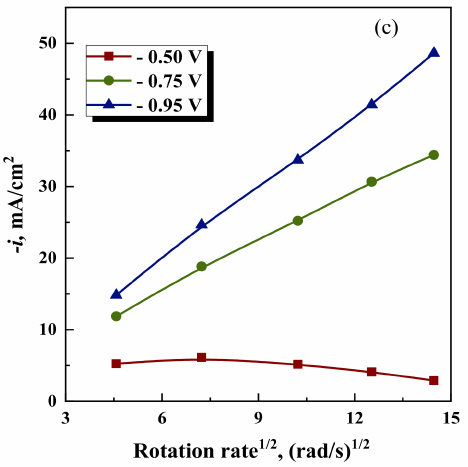
Figure 4. Cathodic current density vs time, at various deposition potentials and rotation rates at 0.2 M Na 2 WO 4 ( a ); Levich plots obtained: for various Na 2 WO 4 concentrations at constant E = − 0.5 V ( b ); and various potentials at 0.2 M Na 2 WO 4 concentration ( c ).